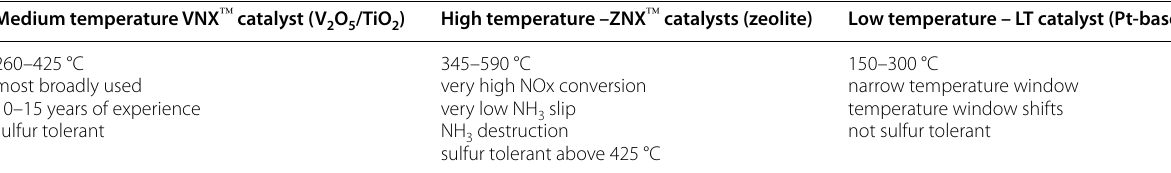
Table 1 Operating characteristics of different SCR catalysts [2] Medium temperature VNX ™ catalyst (V 2 O 5 /TiO 2 ) High temperature –ZNX ™ catalysts